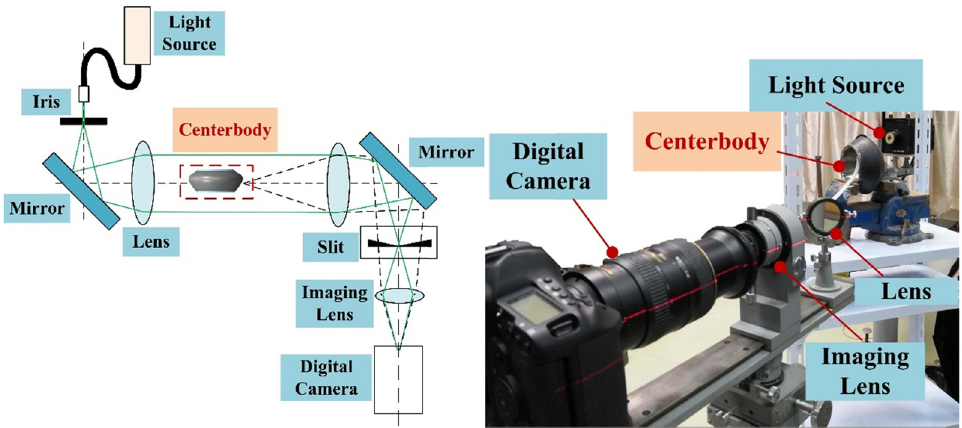
Figure 4: Schematic of Schlieren optical system.